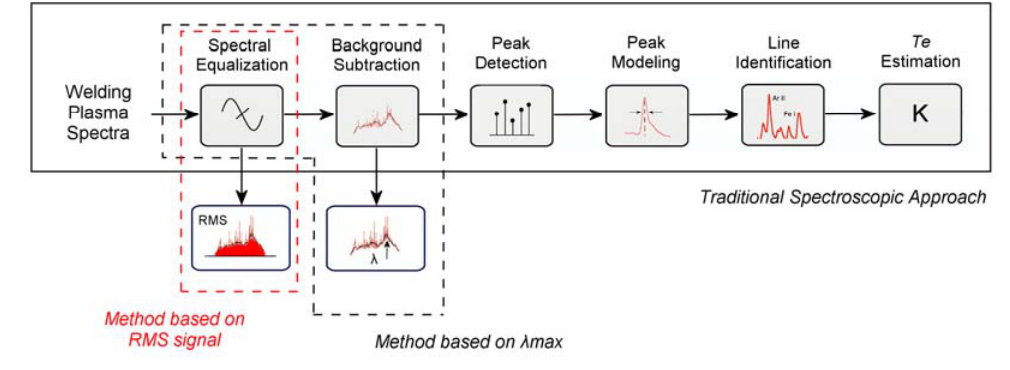
Figure 1. Block diagram of the processing stages involved in the estimation of the monitoring